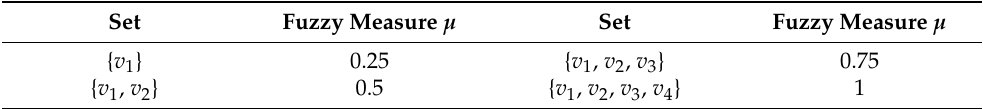
Table 1. The value of uniform fuzzy measure